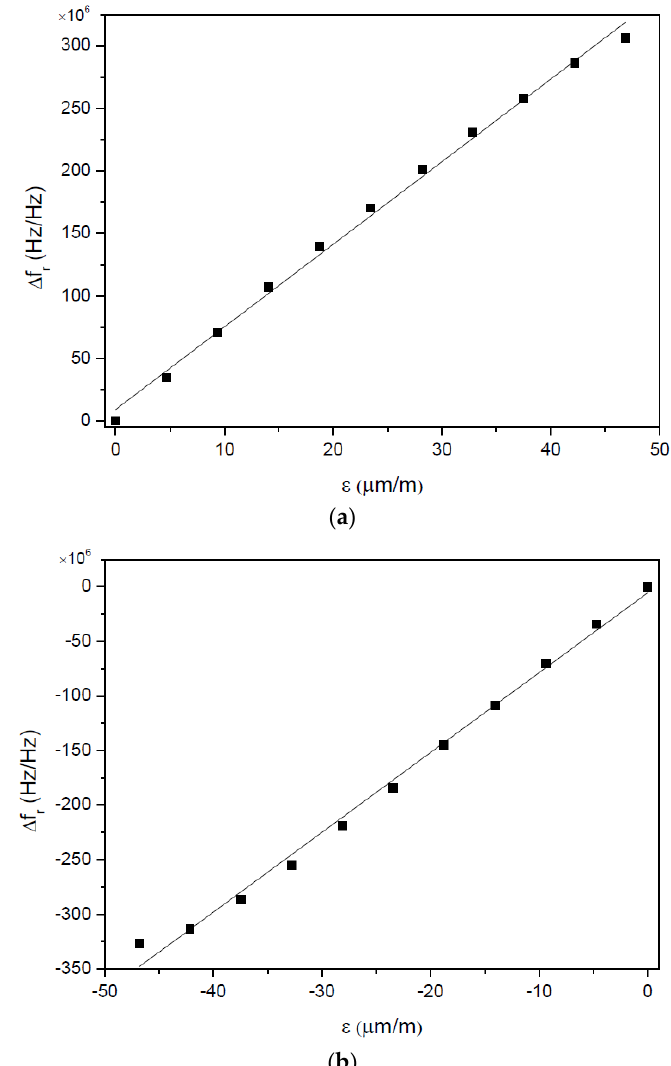
Figure 10. Difference between relative resonant frequencies of gages SSE E015 and SSE E016 for different values of strain applied in ( a ) downward direction and ( b ) upward direction. Values were measured at 25 °C.